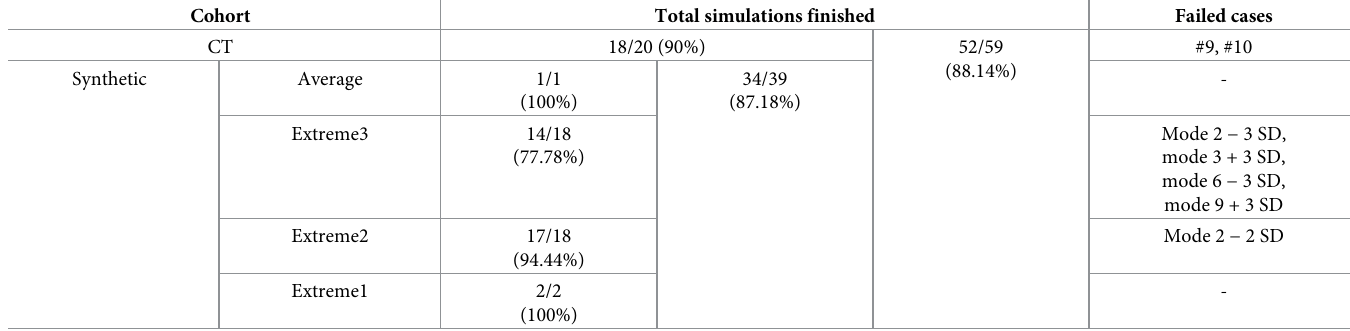
Table 3. Summary of the finished simulations for each cohort and in total. SD stands for standard